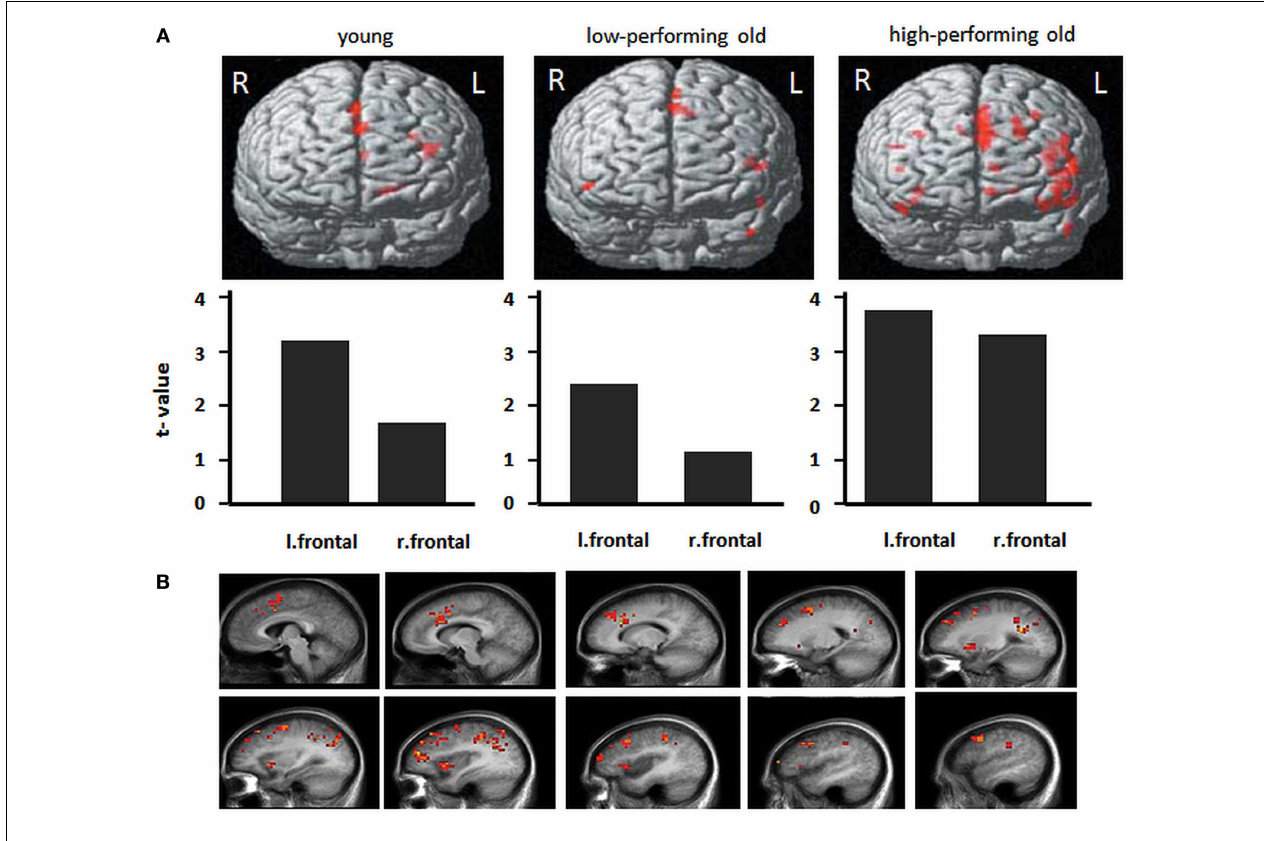
and Gabrieli, 2004). (B) Total sleep deprivation-related patterns of cerebral activation during a verbal learning task. For each of these regions, the memorization of difficult words elicited greater activation after total sleep deprivation than after a night of sleep. Images show left hemisphere slices from 5 to 50mm [adapted from Drummond et al.